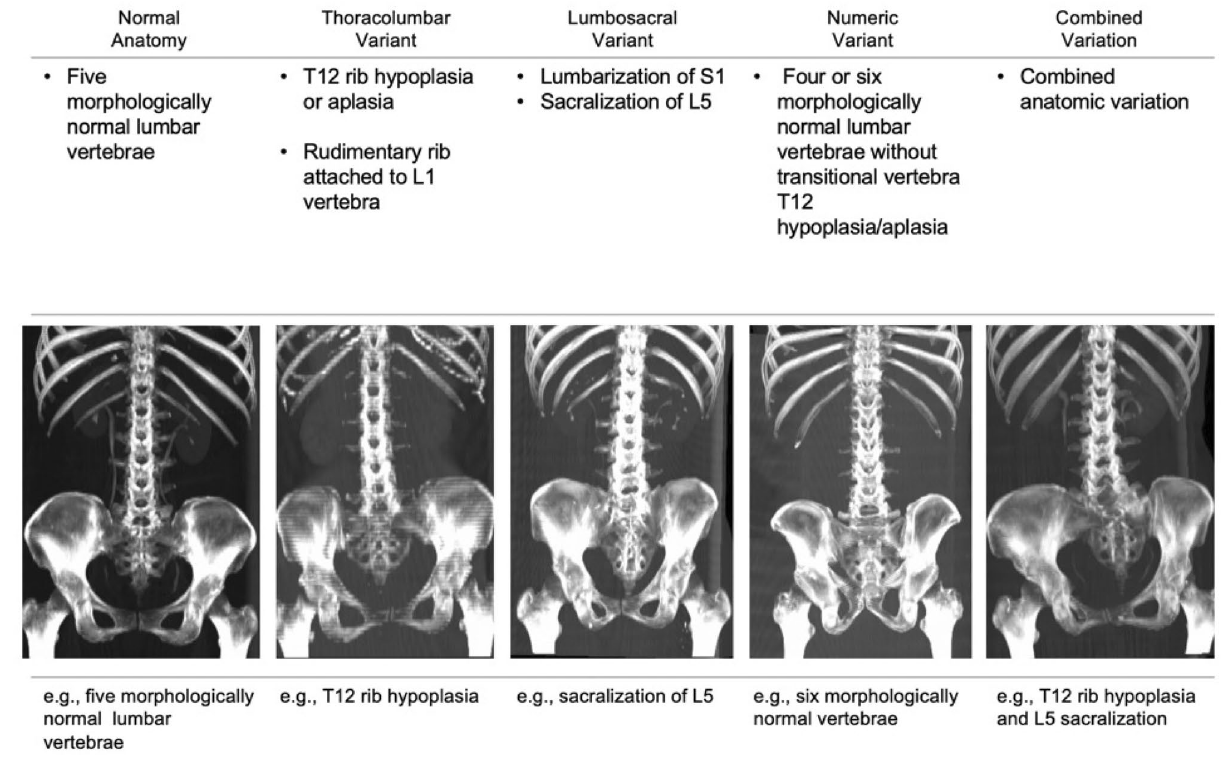
Figure 2. Anatomic lumbar spine variants. Examples of normal, thoracolumbar, lumbosacral, numeric, and combined variations are